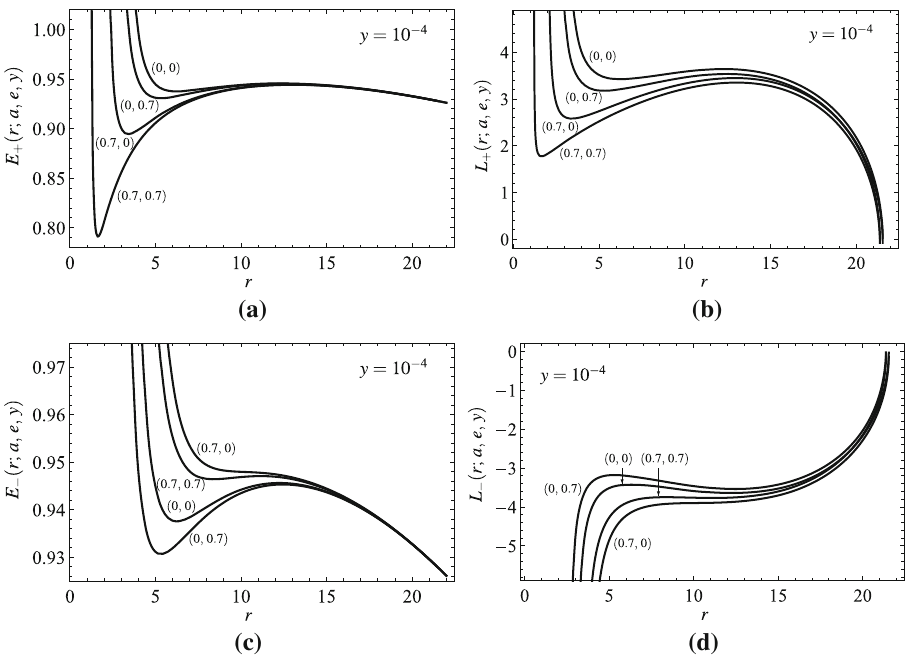
Fig. 2 Radial profiles of specific energy and specific angular momentum of test particles moving on equatorial circular orbits around KNdS black holes with cosmological parameter y = 10 − 4 . Values of corresponding rotational and charge parameters ( a , e ) are assigned to each curve separately. a , b Correspond to the plus-family orbits, while the c , d correspond to the minus-family